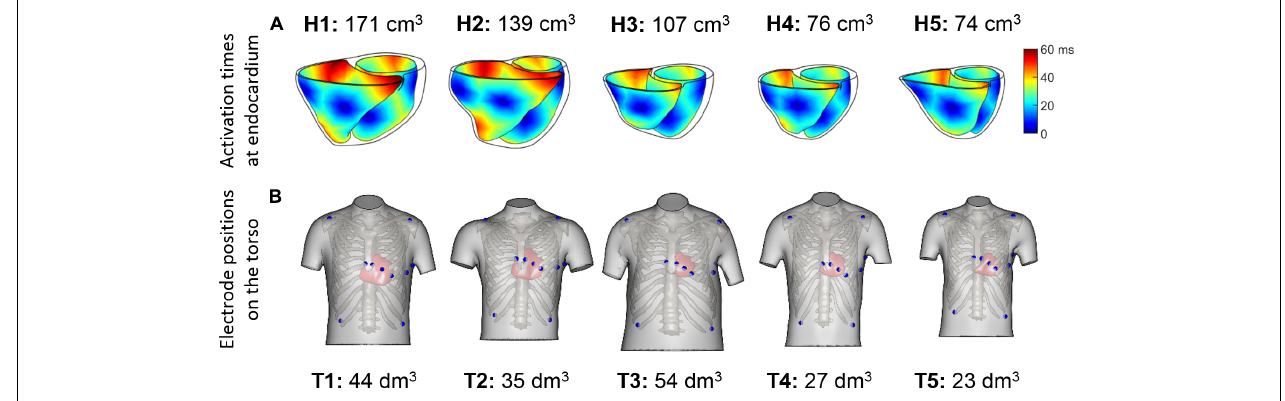
FIGURE 2 | (A) Endocardial activation maps for the five ventricular geometries. Information about ventricular volumes is also provided. (B) Homologous 12-lead electrode positions for the five virtualized subjects. Information about the torso volumes is provided.